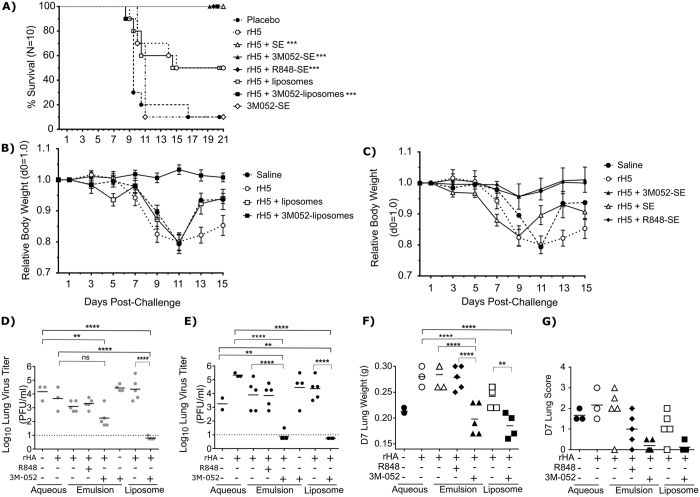
Mice immunized with 3M-052 show enhanced survival following H5N1 challenge.Mice (n = 10/group) were immunized once with rHA protein (A/VN/1203/04, Protein Sciences) in combination with adjuvants as indicated. Adjuvant dose was 1 μg R848 or 2 μg 3M-052. Twenty one days post immunization, animals were challenged with 106 PFU of A/VN/1203/04 (H5N1, Clade 1) via the intra-nasal route. Animals were monitored daily for survival (A) and weight loss (B,C). In the case of weight loss, mean relative body weight within the group is presented, with error bars representing 1 standard deviation from the mean. 3 days (D) and 7 days (E) post-challenge, mice were euthanized, and lung virus titers determined by plaque assay. In addition, intact lungs were weighed at day 7 post-challenge as a measure of consolidation (F), and were scored for the appearance of gross pathology (G). Significance was determined by Mantel-Cox Log-Rank Test (A) or by One-way ANOVA, with Tukey’s correction for multiple comparisons (D–G) (**p < 0.005, ***p < 0.0005, ****p < 0.0001).